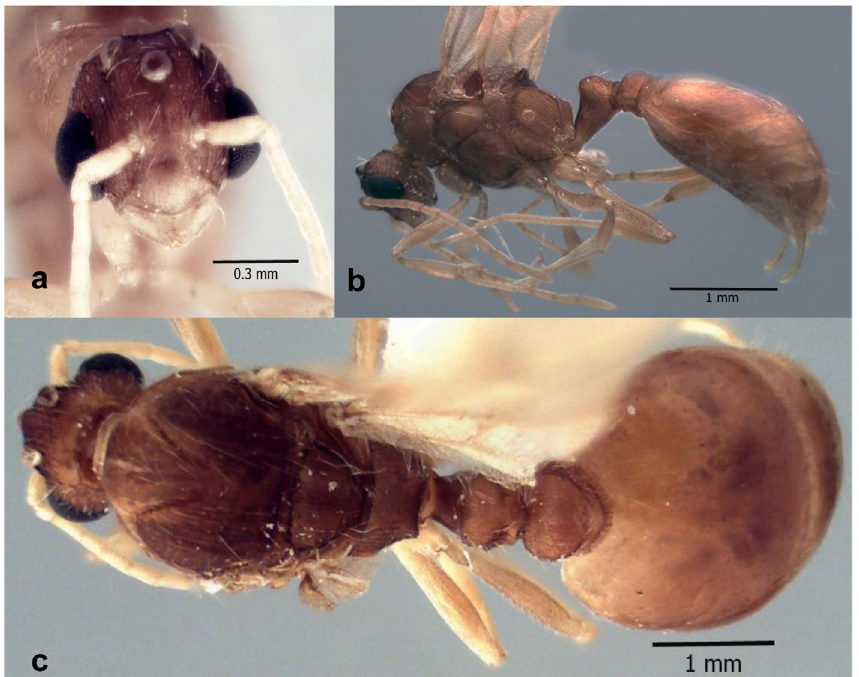
Figs 2a-c . Male of Wasmannia auropunctata . 2a, head in full-face view; 2b, profile; 2c, dorsal